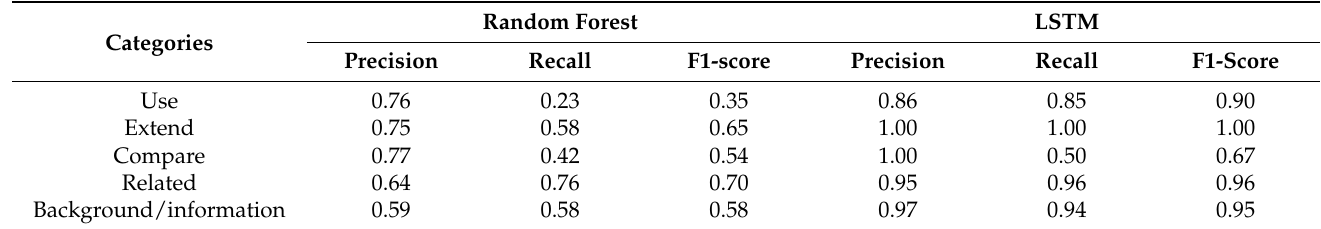
Table 6. Classification metrics by